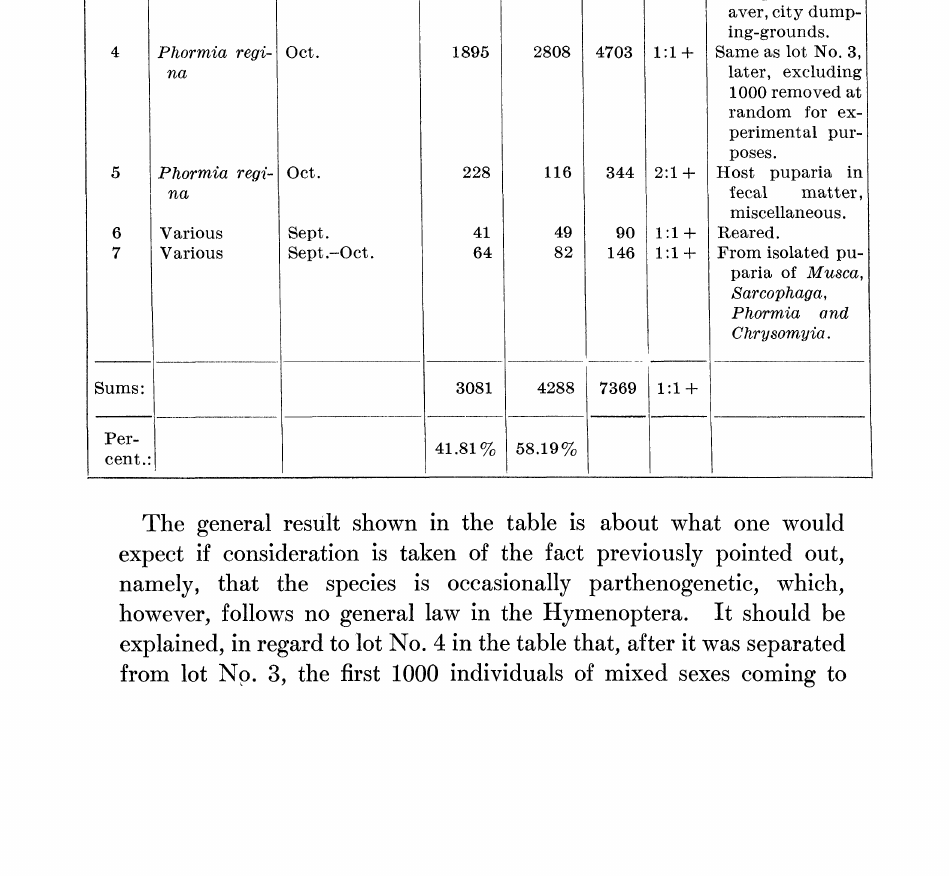
PROPORTION OF THE SEXES IN Nasonia